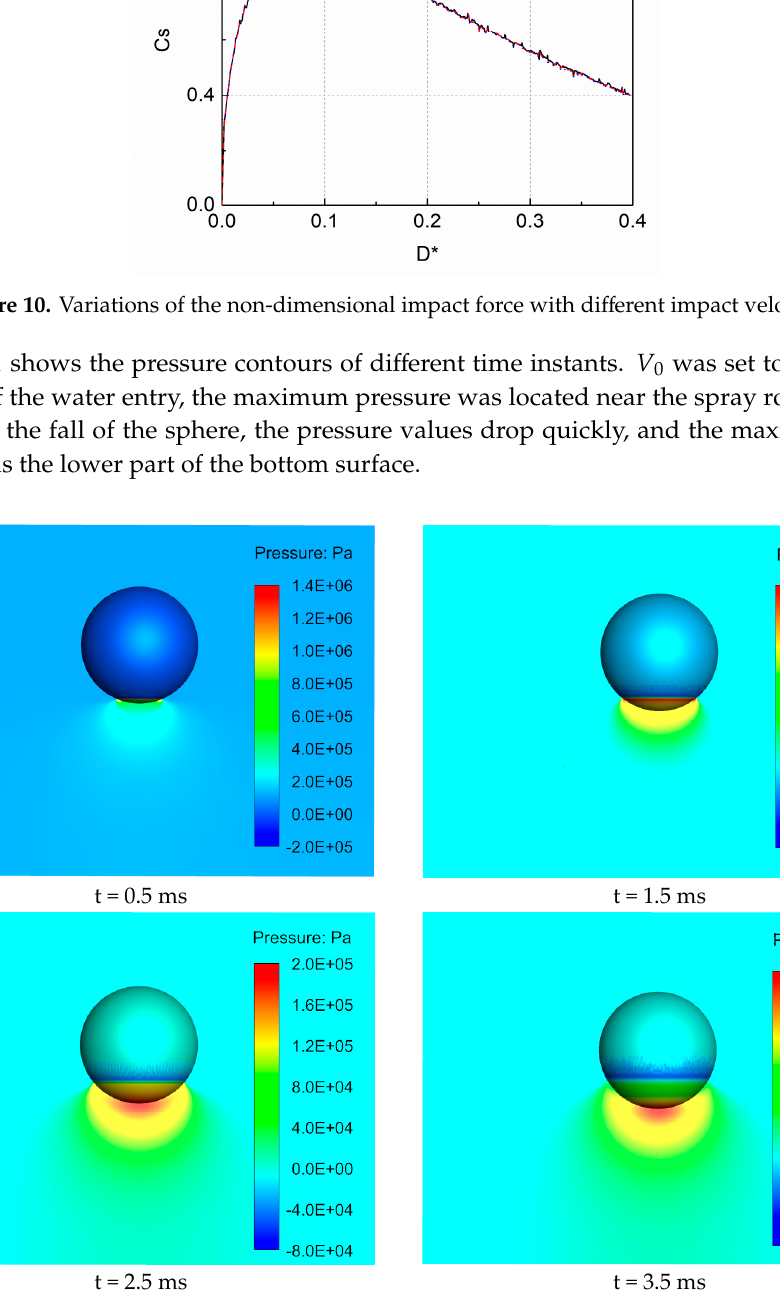
Figure 11. Pressure contours with different time instants.